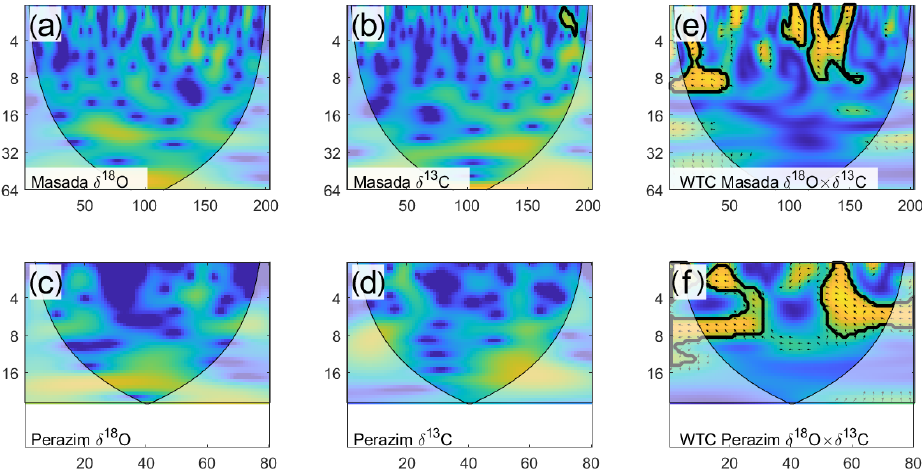
Figure 9. Wavelet (a–d) and wavelet coherence (e–f) analyses of δ 18 O and δ 13 C in two segments of the Masada (30ka) and Perazim (25ka) exposures of the White Cliff Member (Lisan Formation) deposited during the last glacial over the shelf of Lake Lisan. Areas with significance level above 0.95 ( α = 0.05) are marked by a thick black line. Data are from Kolodny et al.